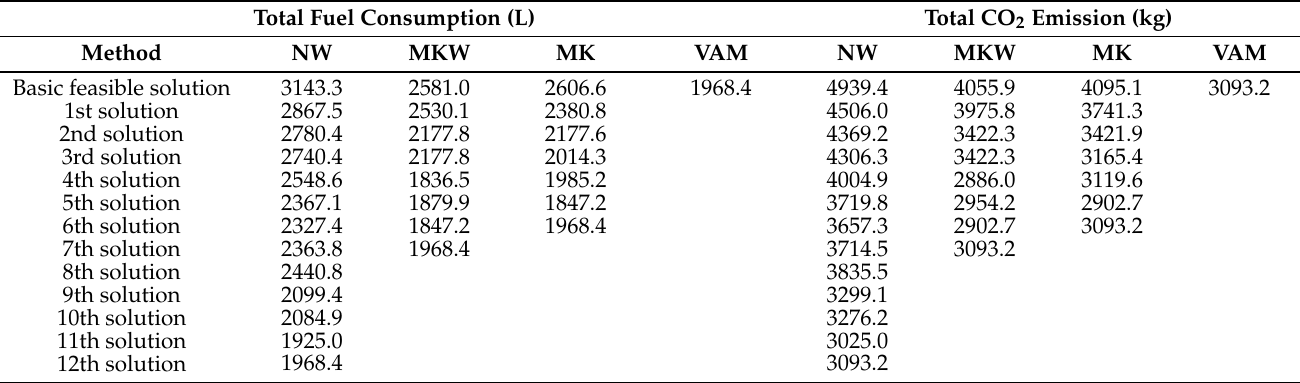
Figure 8. CO 2 emissions (kg) depending on solution obtained. Table 16. Total fuel consumption and total CO 2 emissions as a function of distance